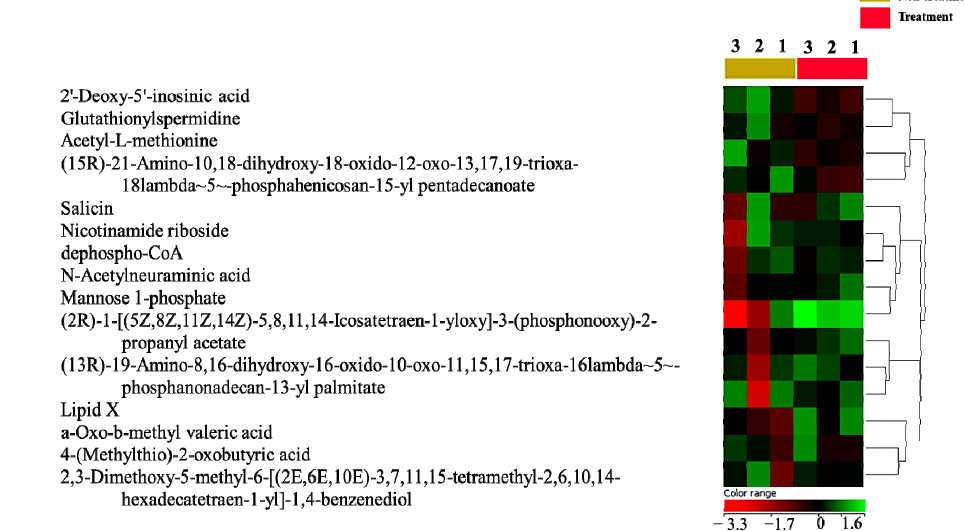
Figure 2. E. coli secretome metabolite identification. A heatmap and hierarchical cluster analysis showed only 15 excreted E. coli metabolites in the culture media of MDA-MB-231 cells compared to the controls’ conditioned media.